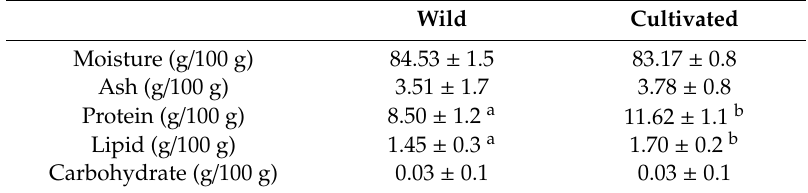
Table 1. Proximate composition of wild and cultivated Flexopecten glaber . Values are average ± SD ( N = 20, n = 3). Means followed by di ff erent letters are significantly di ff erent ( p <